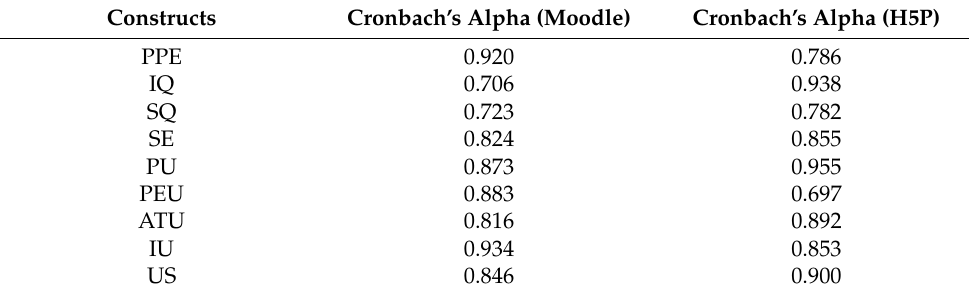
Table 1. The reliability of the items.